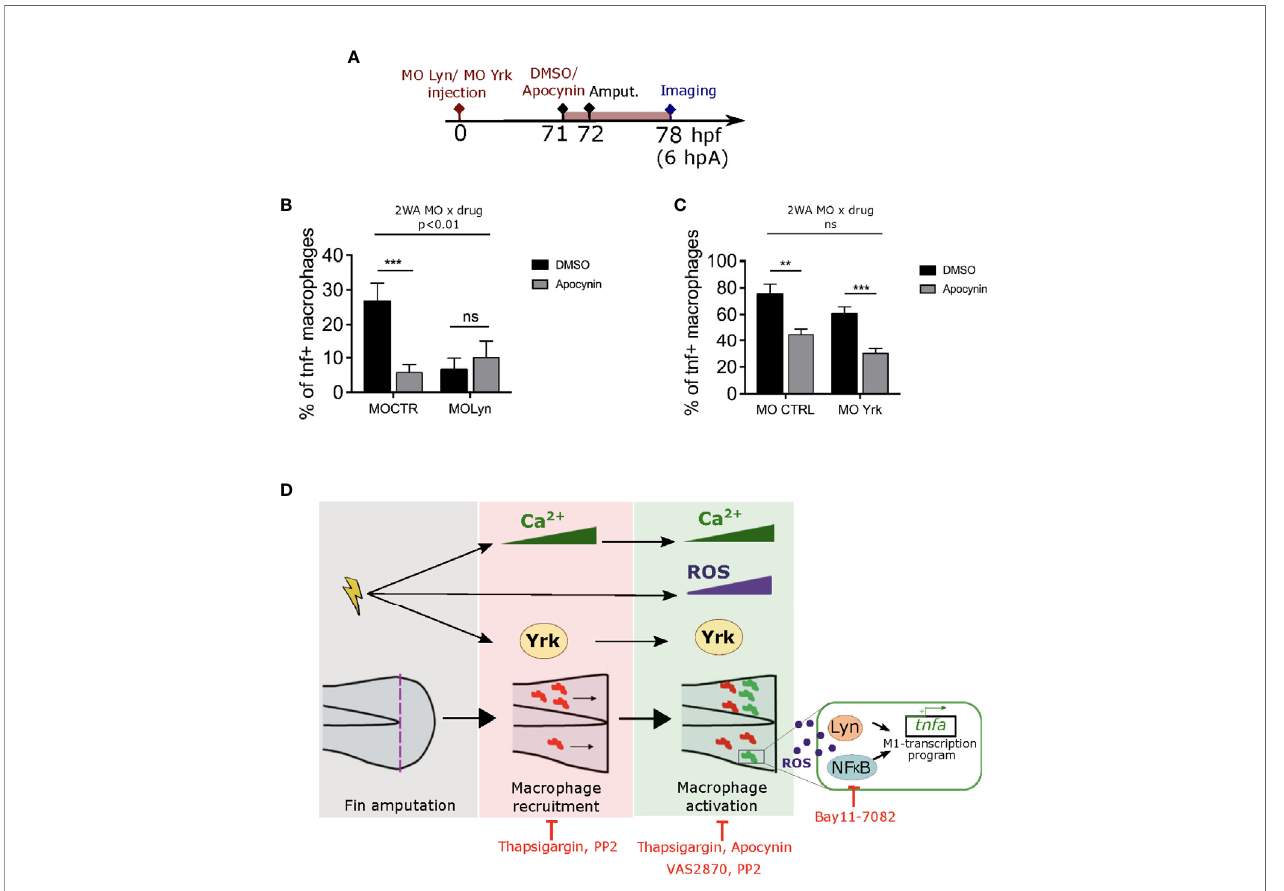
FIGURE 8 | ROS interact with Lyn but not Yrk to mediate macrophage M1-like activation. (A) Schedule of the experiment. Morpholinos targeting speci fi cally lyn (MO Lyn) or yrk (MO Yrk) or morpholino control (MO CTRL) were injected in Tg(mfap4:mCherry/tnfa:GFP-F) at one-cell stage. At 3 dpf (71 hpf), larvae were treated with Apocynin or DMSO, 1 hour before fi n fold amputation. At 6 hpA, tails were imaged using confocal microscopy. (B) Quanti fi cation of the percentage of tnfa + macrophages in the recruited macrophage population at 6 hpA in CTRL morphants or lyn morphants which were either treated with DMSO or Apocynin (mean ± SEM, n larvae is indicated in brackets). A signi fi cant interaction between morpholino and drug effect was determined by two-way ANOVA (2WA, **p<0. 01, F(1, 42) = 8.305). Then Mann Whitney test, two-tailed was performed to determine the signi fi cant difference between DMSO and Apocynin groups (ns-not signi fi cant, ***p<0.001). (C) Quanti fi cation of the percentage of tnfa + macrophages in the recruited macrophage population at 6 hpA in CTRL morphants or yrk morphants which were treated with DMSO or Apocynin. (Representative experiment of two independent experiments, mean ± SEM, n larvae is indicated in brackets). No signi fi cant